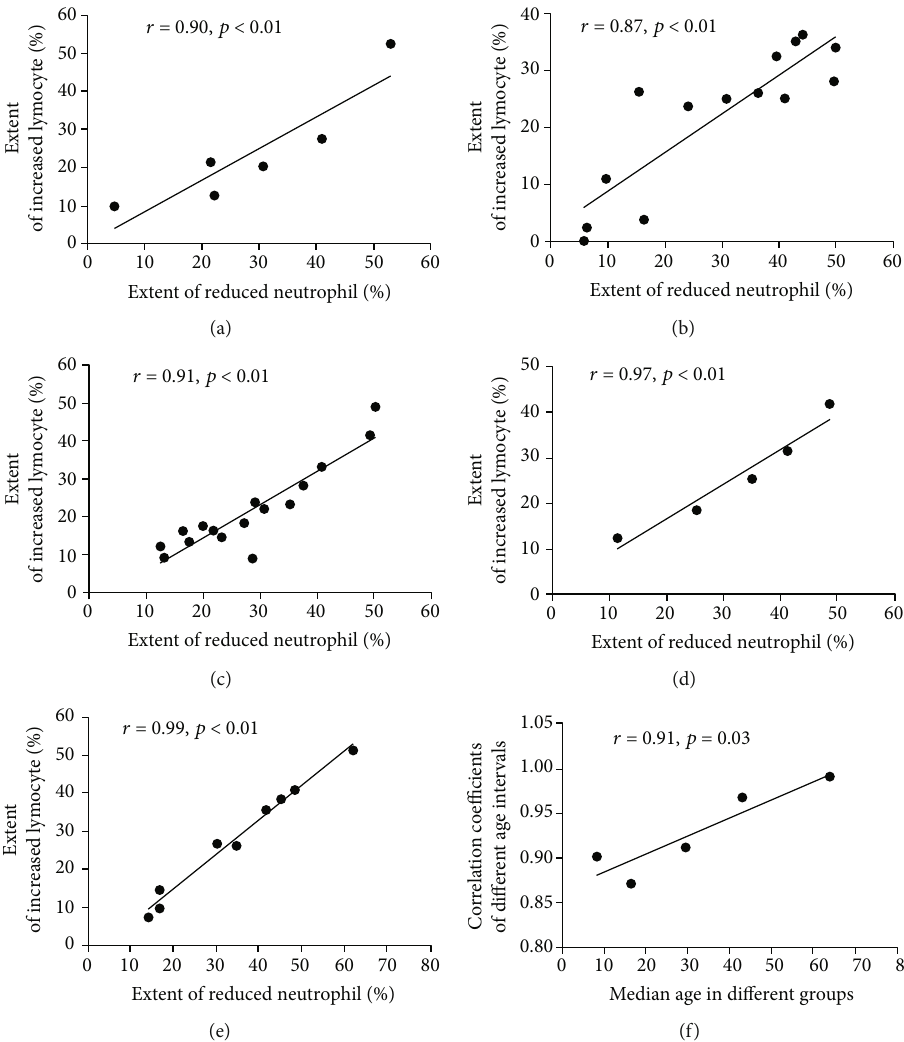
Figure 2: The reduced neutrophil percentages were positively correlated with the increased lymphocyte percentages following treatment with IVIG in all groups. Grouped by age from young to old, the Spearman correlation coe ffi cient ( r ) between the reduced neutrophil percentages and the increased lymphocyte percentages following IVIG was 0.90 ( n = 6 ), 0.87 ( n = 14 ), 0.91 ( n = 16 ), 0.97 ( n = 5 ), and 0.99 ( n = 9 ), respectively. Children were divided into fi ve groups based on age: (a) < 1, (b) 1-2, (c) 2-3, (d) 3-4, and (e) ≥ 4 years. (f) Positive correlation between the coe ffi cients from the changes in neutrophils and lymphocytes and the median ages of children in all groups. r = 0 : 91 , p = 0 : 03 . IVIG: immunoglobulin